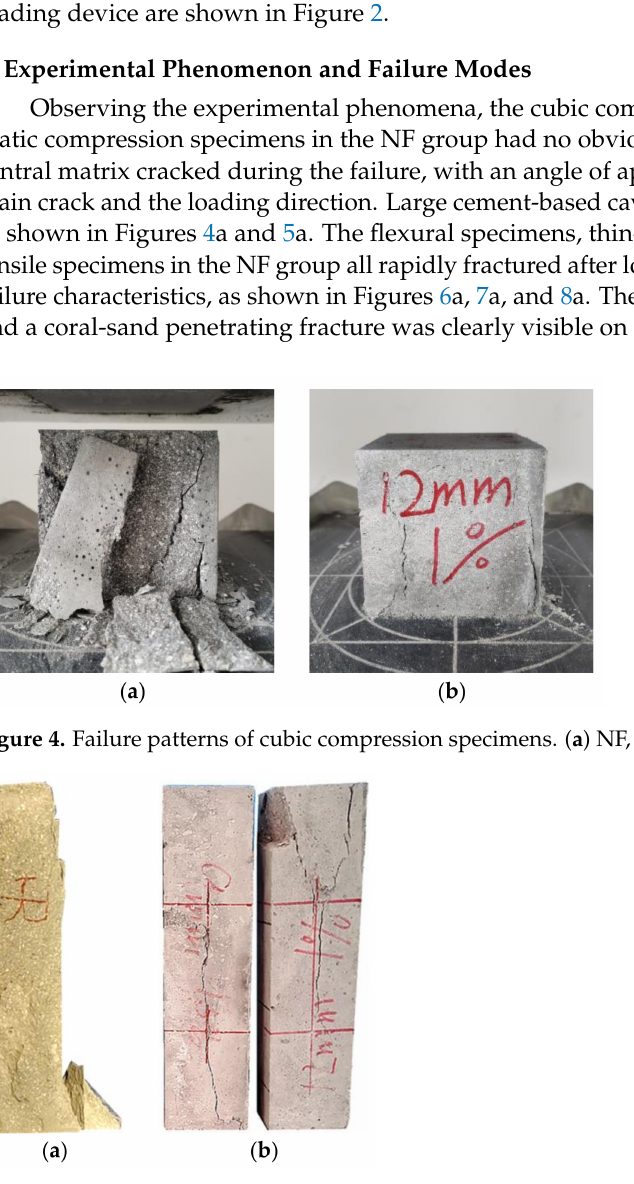
Figure 5. Failure patterns of axial compression specimens. ( a ) NF, ( b )